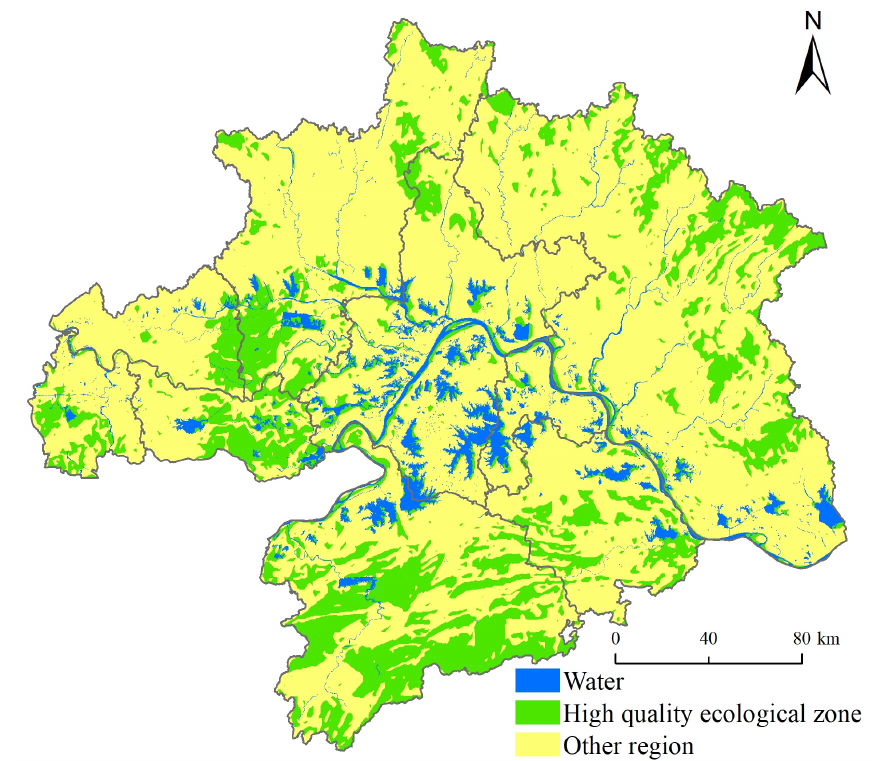
Figure 6. High ecological quality zone in WUAA over 2000 to 2020.